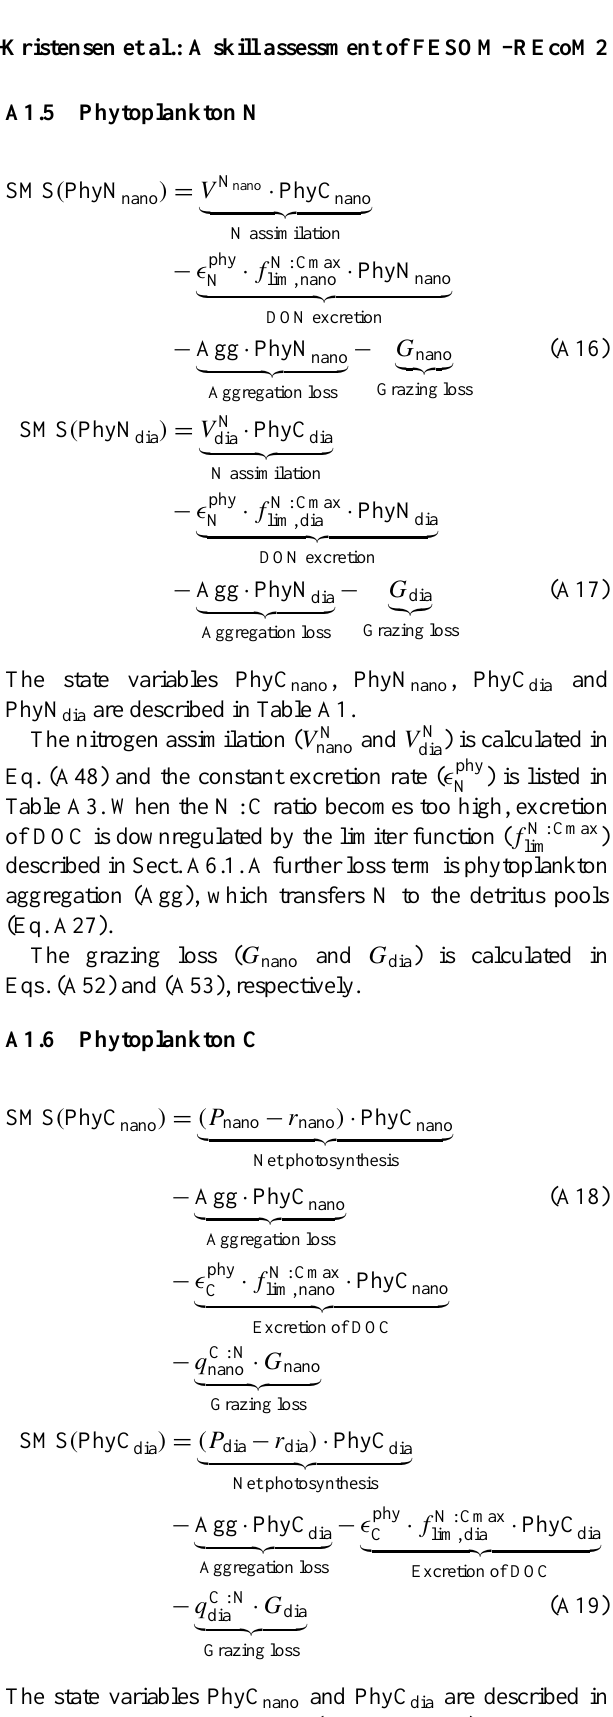
Table A1. The photosynthesis ( P nano and P dia ) is